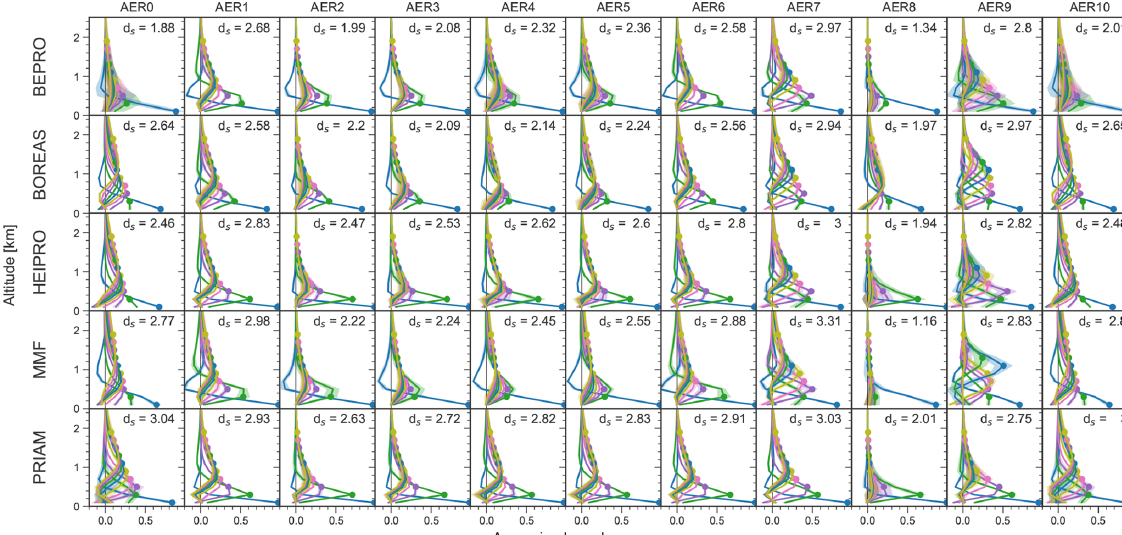
Figure 8. Same as Fig. 5, but for NO 2 .